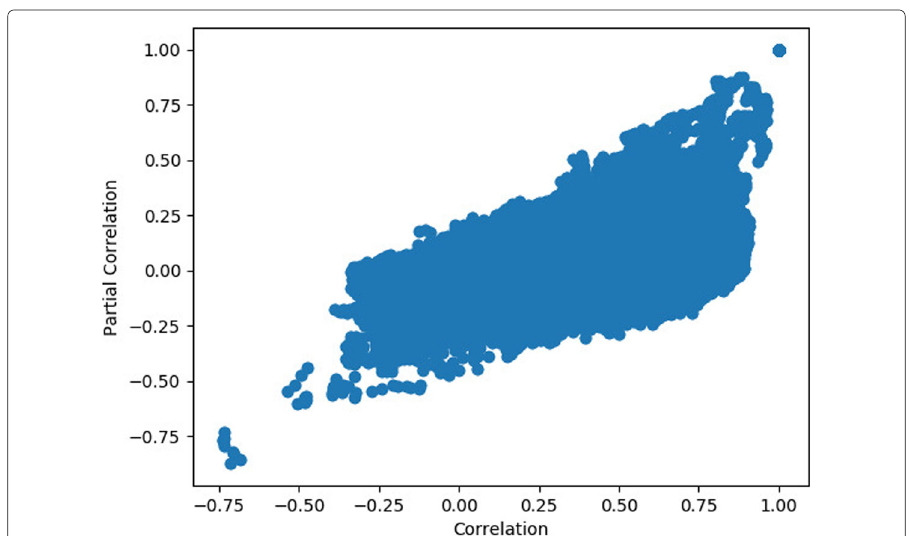
Fig. 4 Scatter plot of the correlation coefficient for an edge against that of the partial correlation coefficient for each of the 140 networks in the dataset. The partial correlation coefficients are in general smaller than their corresponding correlation coefficients which is to be expected if the indirect correlations and reduced, however there is still a relationship between the two